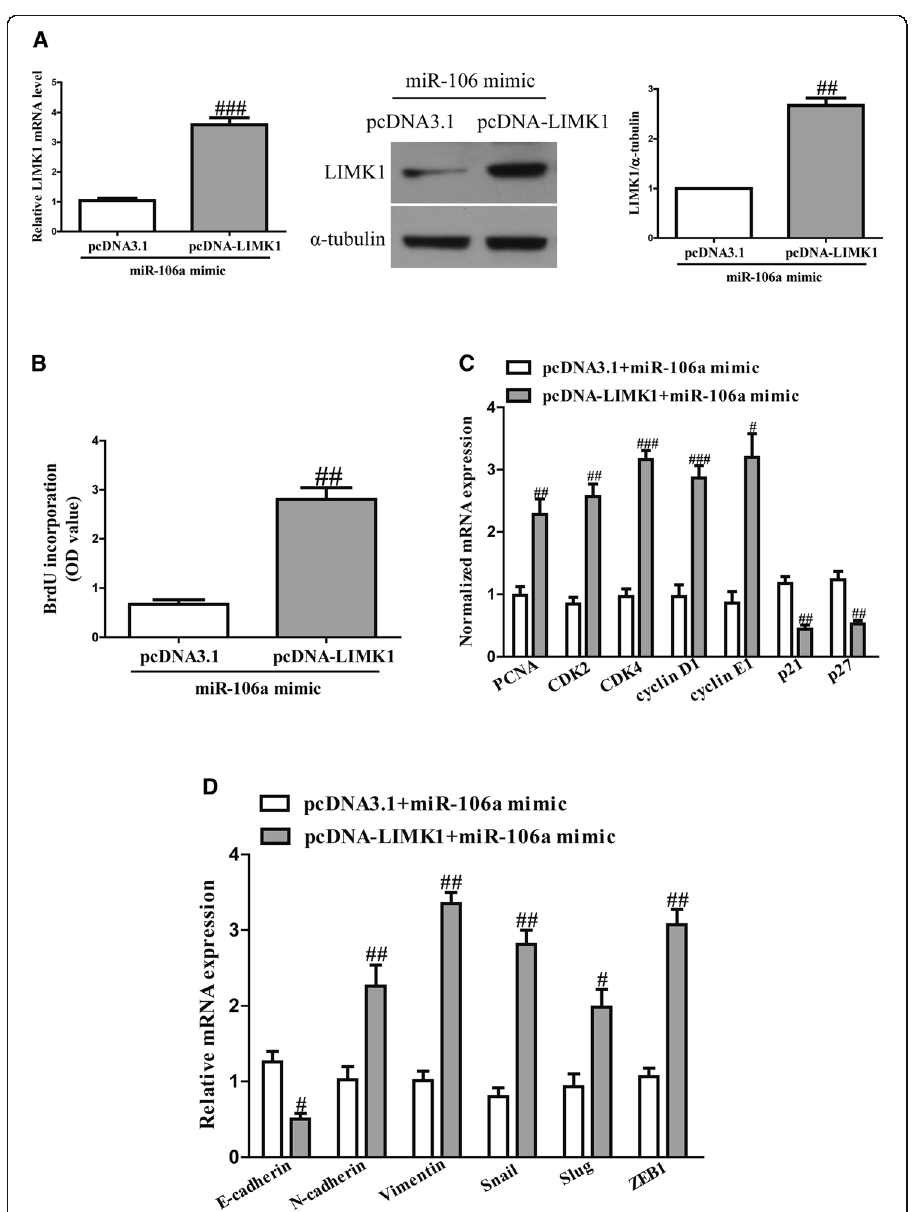
Fig. 6 Introduction of LIMK1 partially promoted cell proliferation and EMT in miR-106a-overexpressing OSCC cells. SCC4 cells were transfected with an miR-106a mimic with or without pcDNA-LIMK1 vector. a The mRNA and protein expressions of LIMK1 were determined via quantitative RT-PCR and western blot assays, respectively. b Cell proliferation was assessed using a BrdU-ELISA assay. c The mRNA expressions of PCNA, CDK2, CDK4, cyclin D1, cyclin E1, p21 and p27 were determined using quantitative RT-PCR. d The expressions of E-cadherin, N-cadherin, vimentin, SNAIL, SLUG and ZEB1 were determined via quantitative RT-PCR. All data are presented as means ± SEM, n = 6. # p < 0.05, ## p < 0.01, ### p < 0.001 vs. pcDNA3.1 +